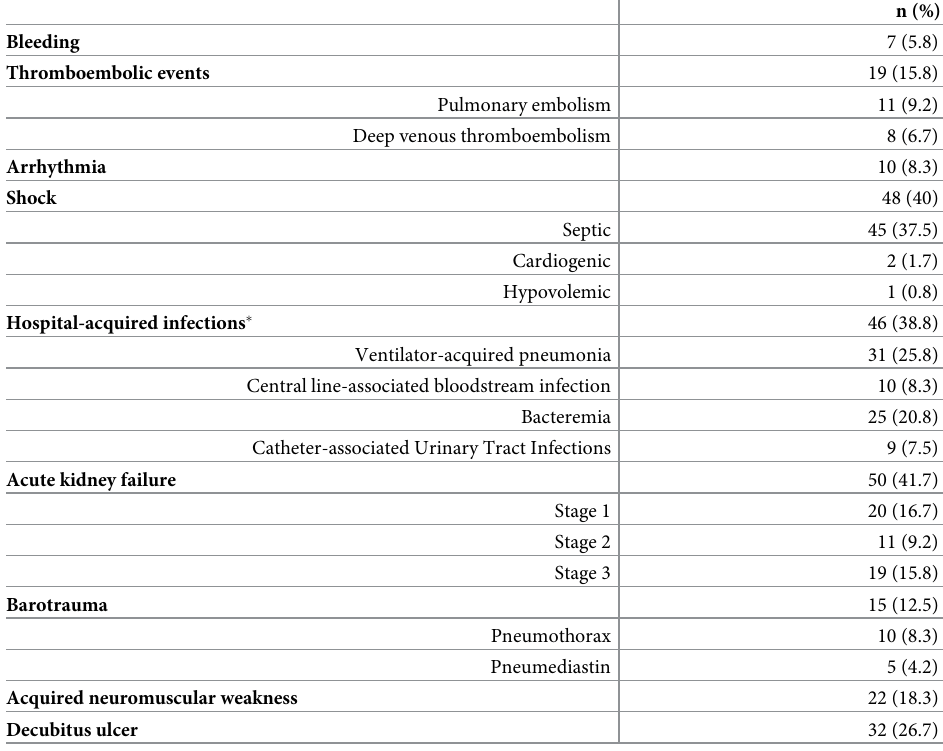
Table 3. Complications among 120 ICU patients with influenza